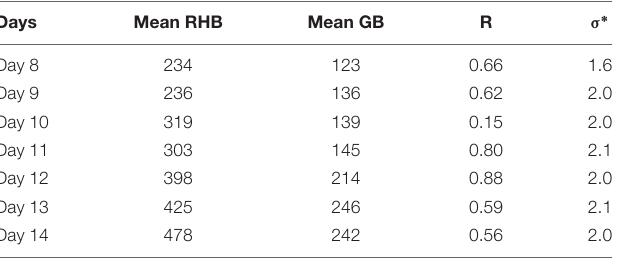
TABLE 4 | Pattern statistics of the courtship associated sounds at RHB and GB.